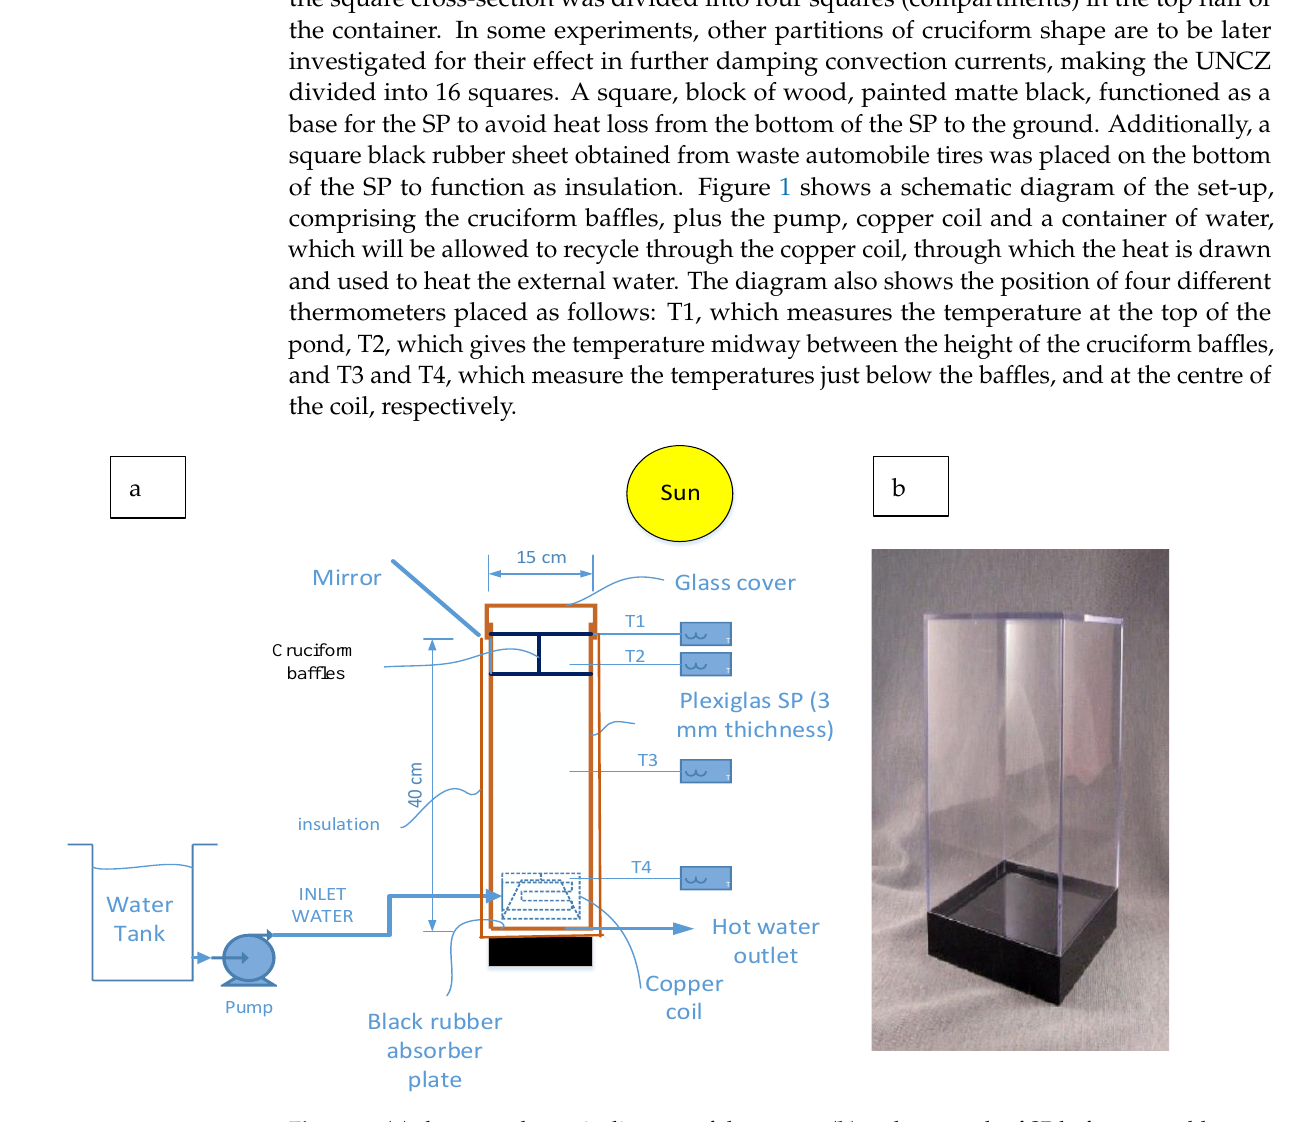
Figure 1. ( a ) shows a schematic diagram of the set-up; ( b ) a photograph of SP before assembly.